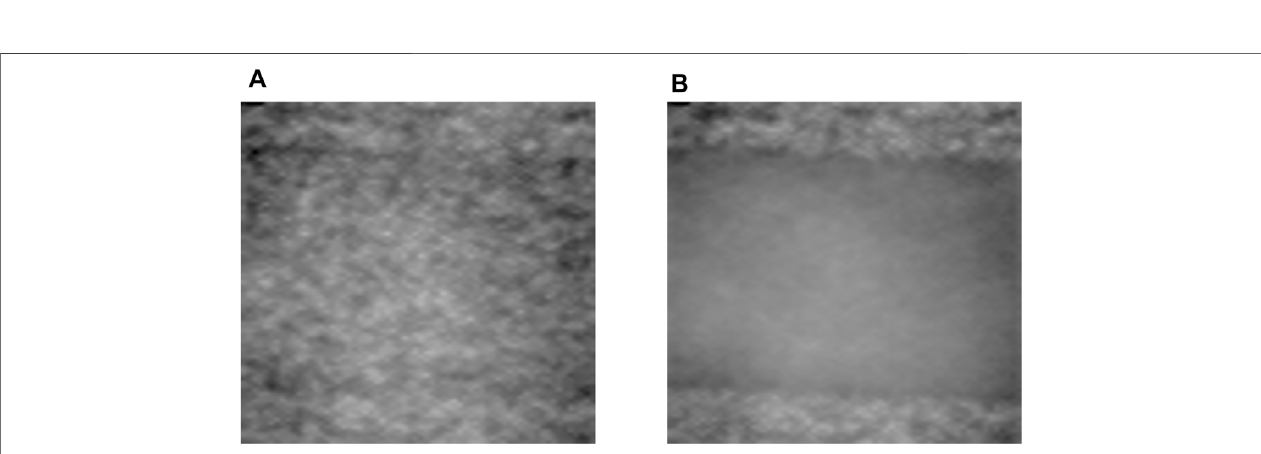
FIGURE 4 | Speckle image scattered from the sample with fl ow rates at (A) 0 cm/s and (B) 5 cm/s.